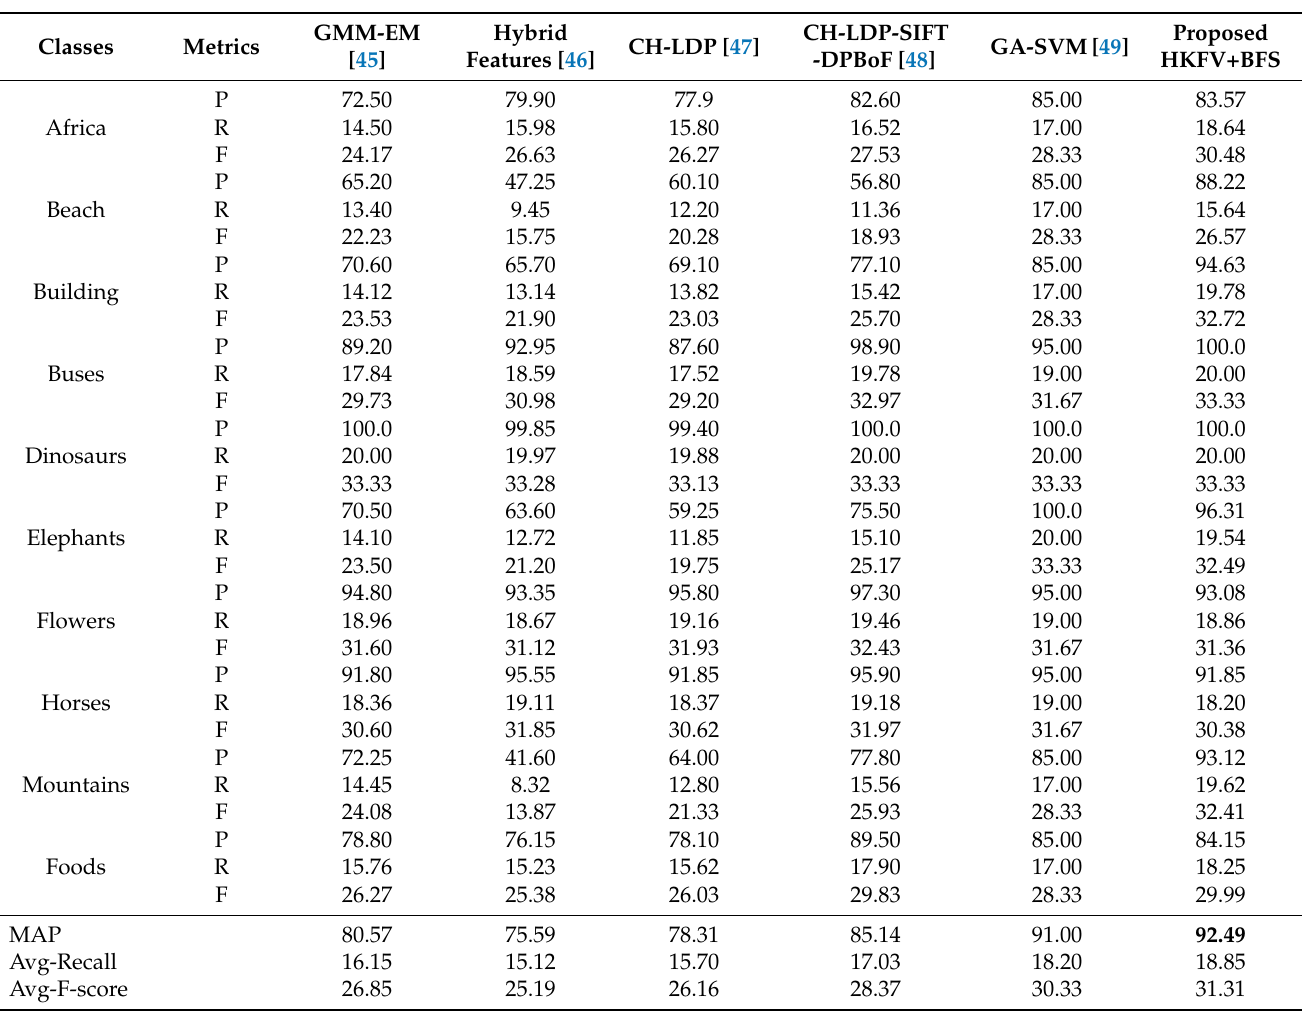
Table 5. Comparison between metrics the recent proposed CBIR approaches on the Corel-1000 and the proposed